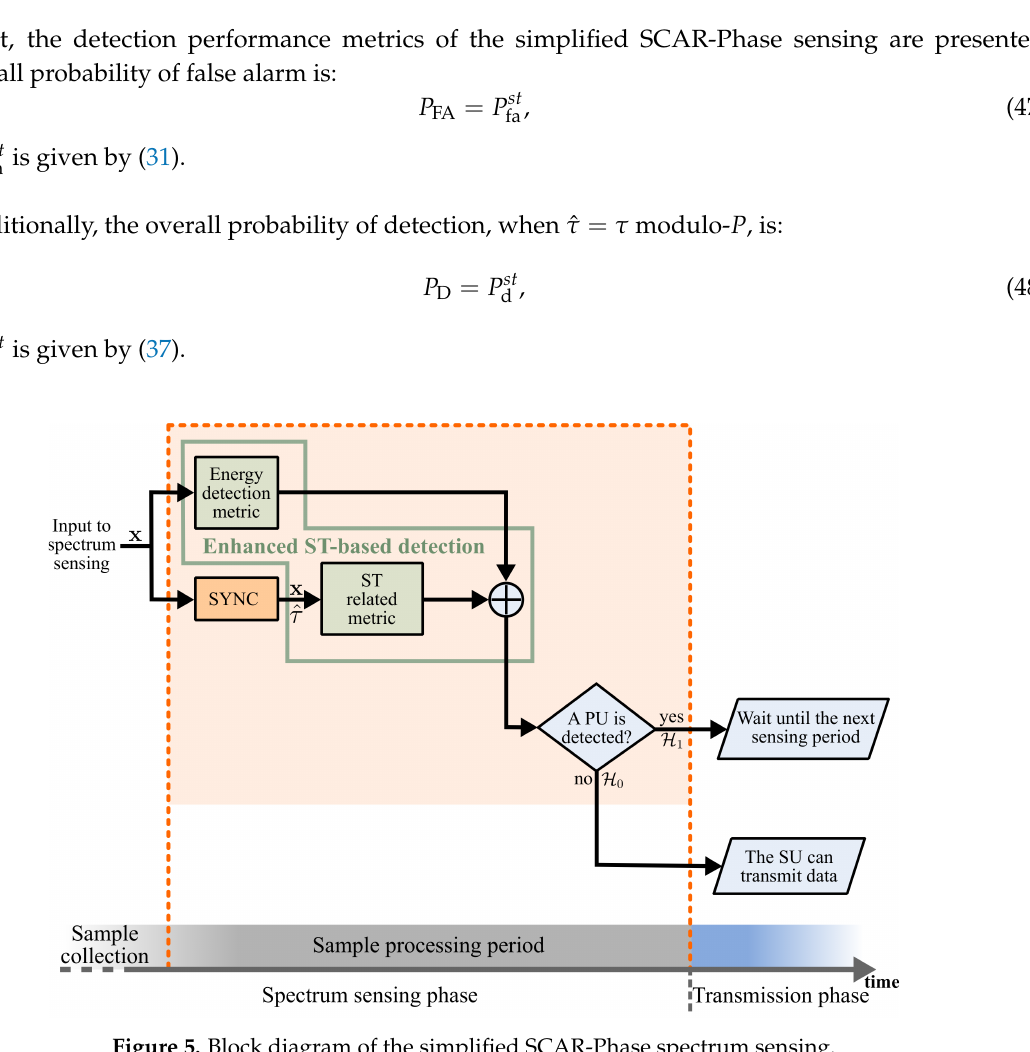
Figure 5. Block diagram of the simplified SCAR-Phase spectrum